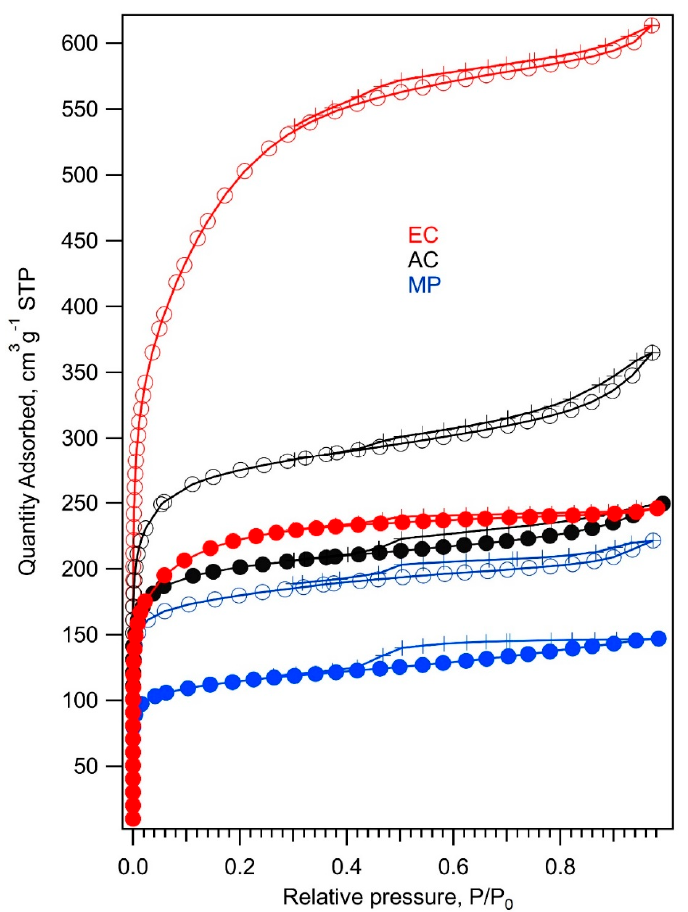
Table 1. Structural parameters of carbonaceous additives.